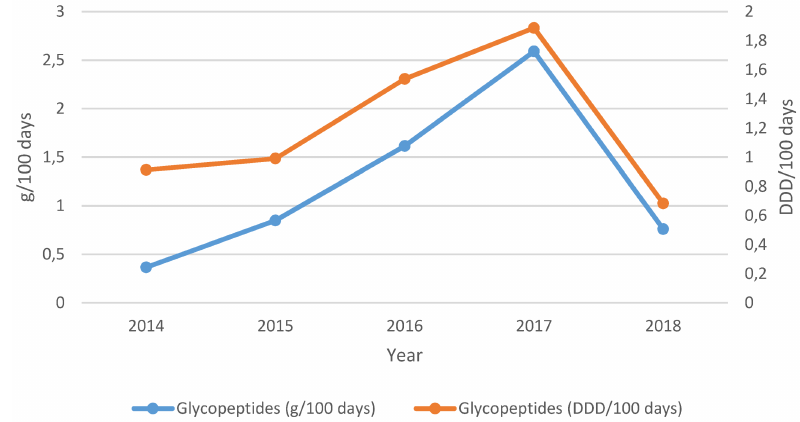
Figure 5: Glycopeptided, general pediatrics